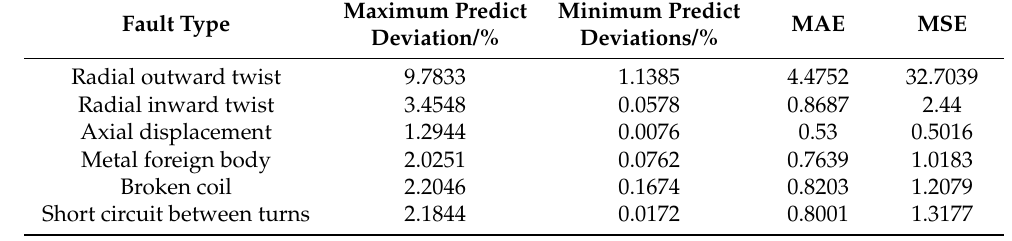
Table 3. Performance of regression model under each fault type. MAE: Mean Absolute Error; MSE: Mean Square Error.